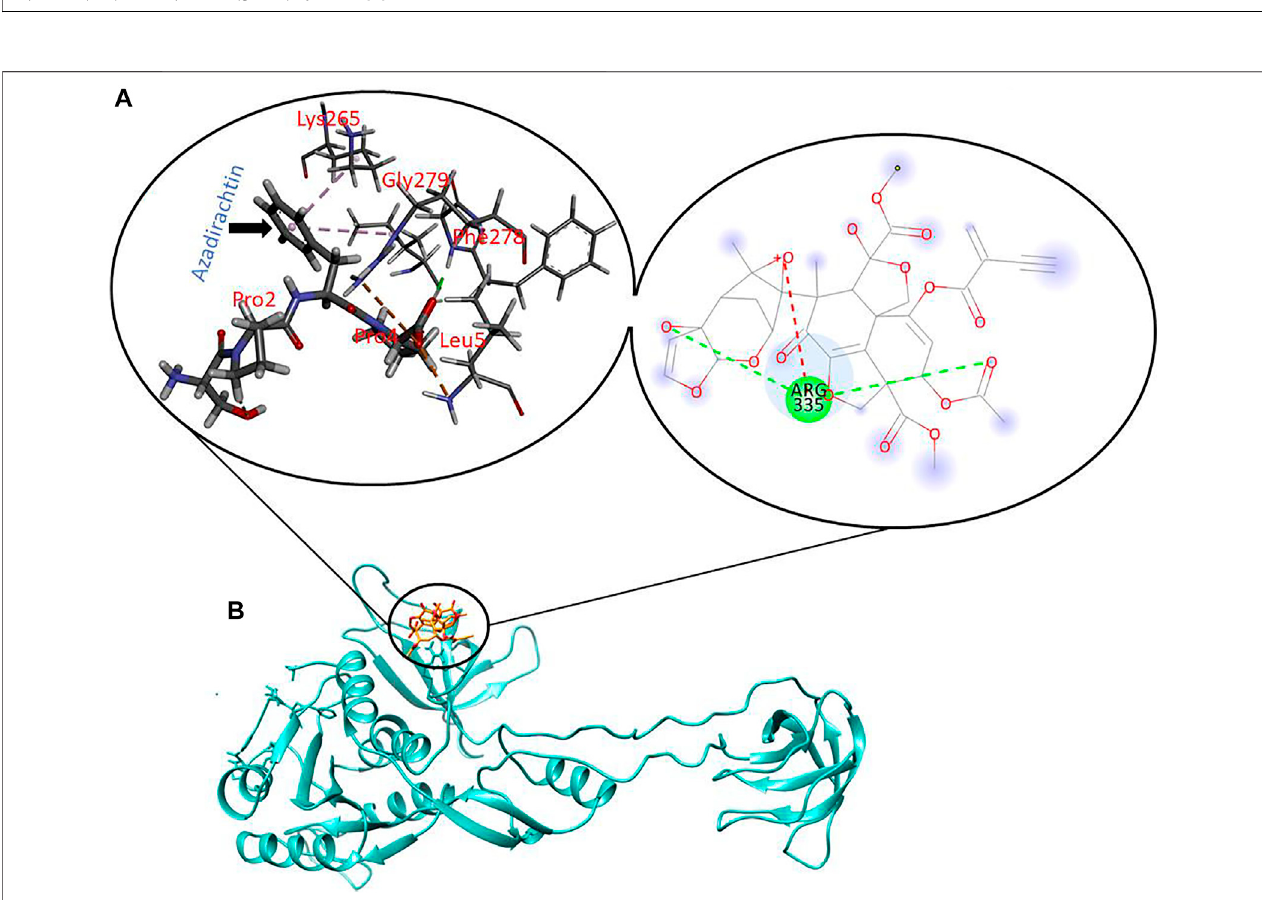
FIGURE 2 | Molecular interactions between key residues and reactive moieties in Gephyrin (A) . 3D structure of Azadirachtin in the active site of Gephyrin (B) .